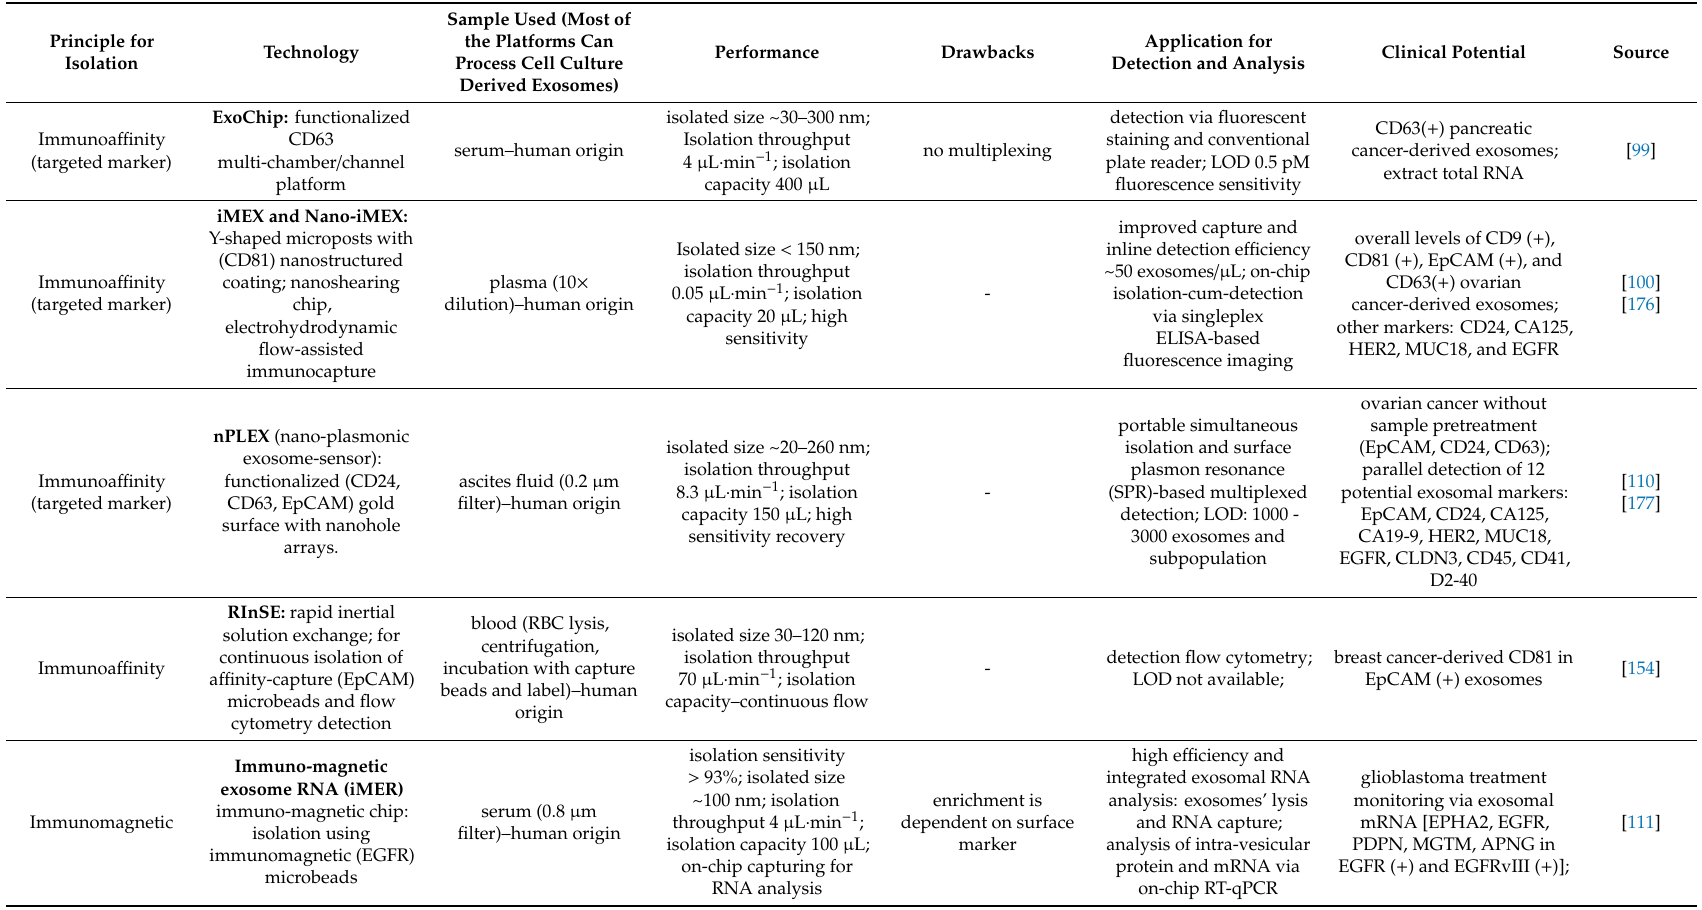
Table A1. The most common microfluidic approaches for exosomes’